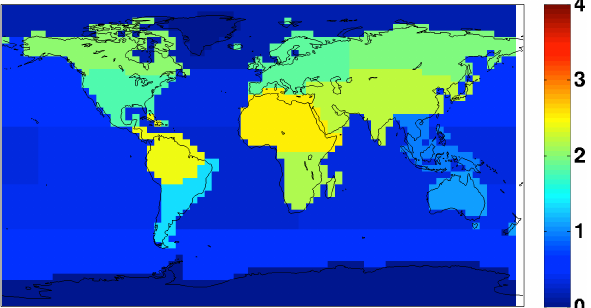
Figure 3. Prior flux uncertainty for the TransCom3 regions (in PgCyear − 1 ) as used in the Jena inversion scheme.